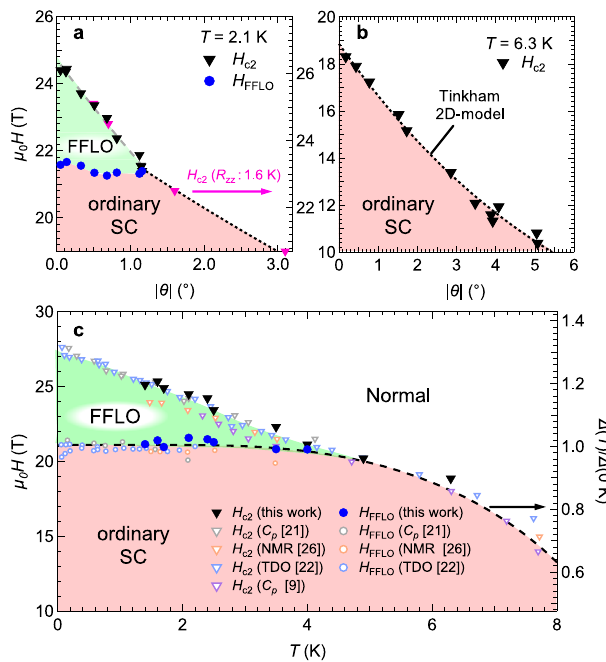
Fig. 3 | Superconducting phase diagrams. a , b Upper critical fi eld H c2 (black triangles) as a function of the absolute value of the fi eld angle| θ | at a 2.1K and b 6.3K. The blue circles in a indicate transition fi elds to the FFLO state H FFLO . The green and red areas represent the regions for the FFLO phase and ordinary superconducting phase, respectively. The dotted curves in a , b are fi ts to the Tinkham 2D model, | H c2 ( θ )cos θ / H c2 (90°)|+( H c2 ( θ )sin θ / H c2 (0°)) 2 =1. c Field- temperaturesuperconductingphasediagramobtainedinthiswork( fi lledsymbols) and previous reports (blank symbols) 9,21,22,26 . The dashed curve (right axis) is the temperature dependence of the reduced superconducting gap amplitude Δ ( T )/ Δ (0K) calculated by the basic BCS